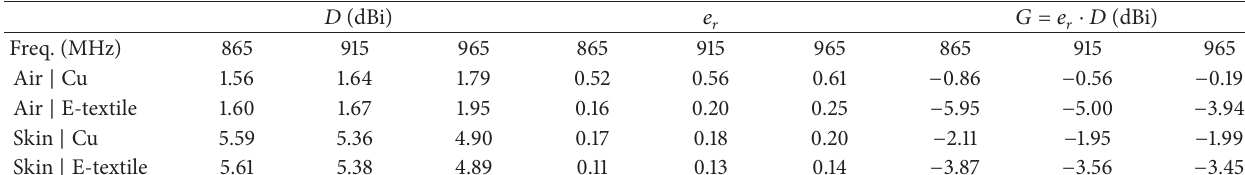
Table 1: Simulated radiation properties of the antenna.